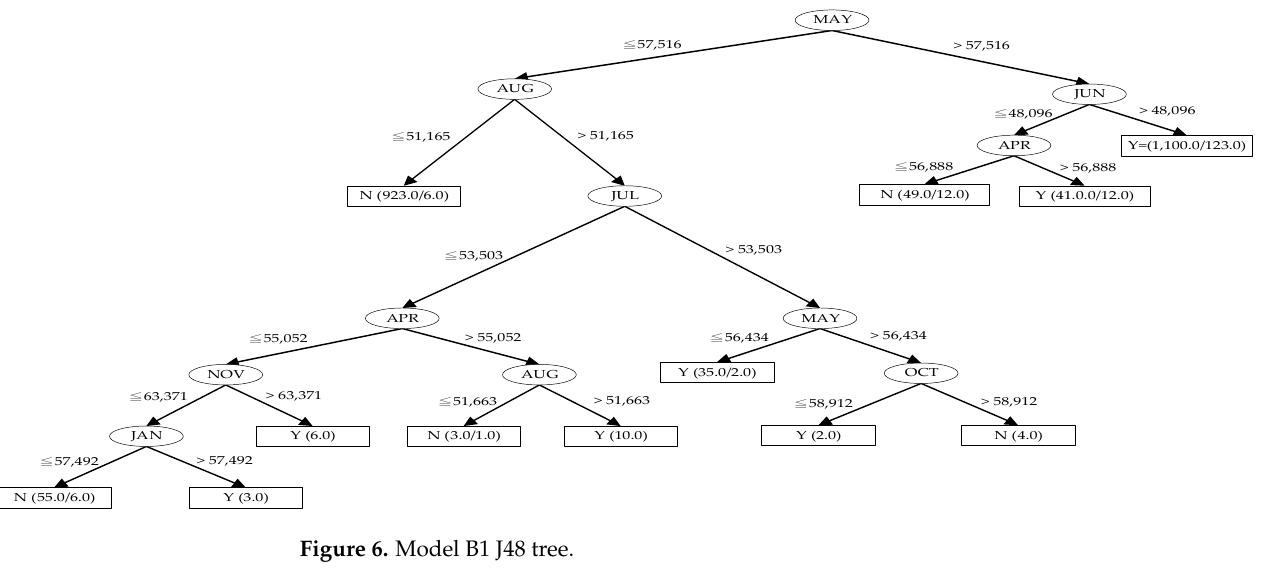
Figure 6. Model B1 J48 tree.